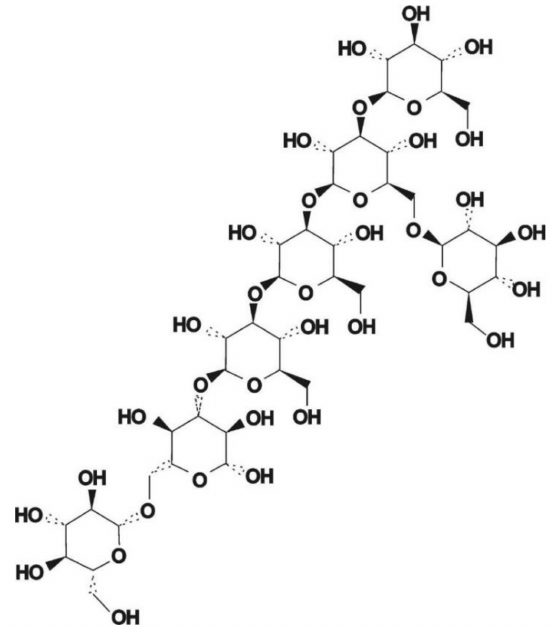
Figure 11. Lentinan. Reprinted with permission from Ref. [118]. Copyright 2022,